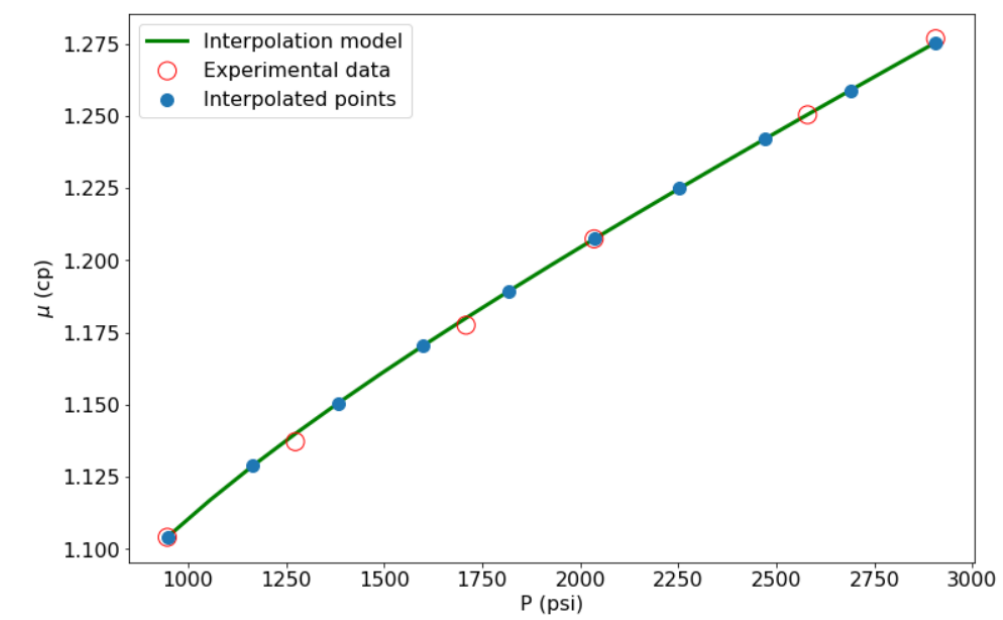
Figure 1. Example of experimental data resampling by means of interpolation (green